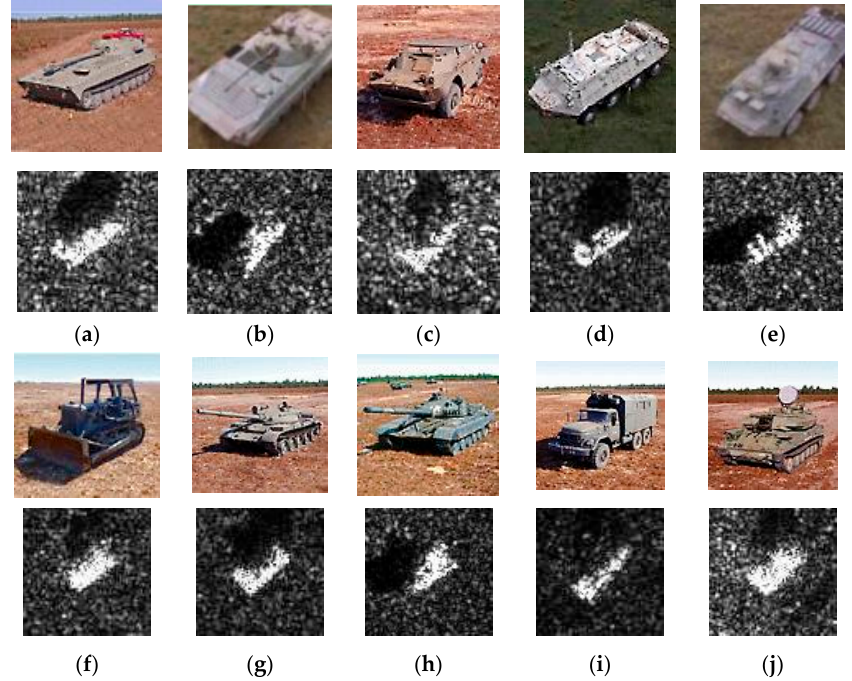
Figure 6. Ten classes of target images from MSTAR: ( a ) 2S1, ( b ) BMP-2, ( c ) BRDM-2, ( d ) BTR-60, ( e ) BTR-70, ( f ) D-7, ( g ) T-62, ( h ) T-72, ( i ) ZIL-131, and ( j ) ZSU-234.